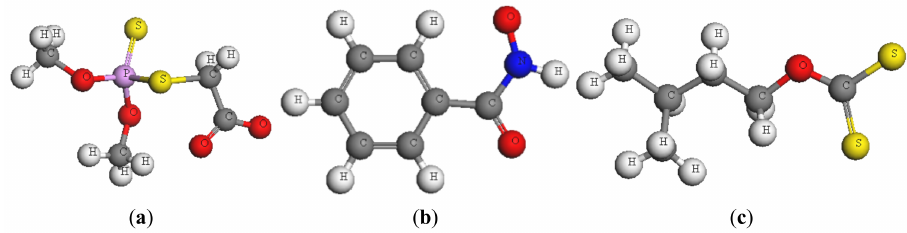
Figure 13. ( a ) Optimization model of CDDP − ; ( b ) optimization model of BHA − ; ( c ) optimization model of C 5 H 11 OCSS − .